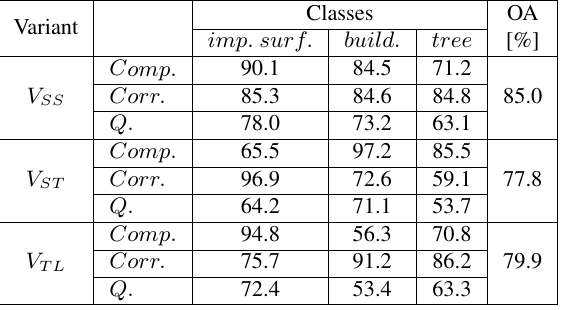
Table 1: Overall accuracy [%], completeness ( Comp: ), cor- rectness ( Corr: ) and quality ( Q: ) values [%] for the classes impervious surfaces ( imp: surf: ), building ( build: ) and tree , obtained for the three variants of the test ( V SS , V ST , V TL ) explained in the main